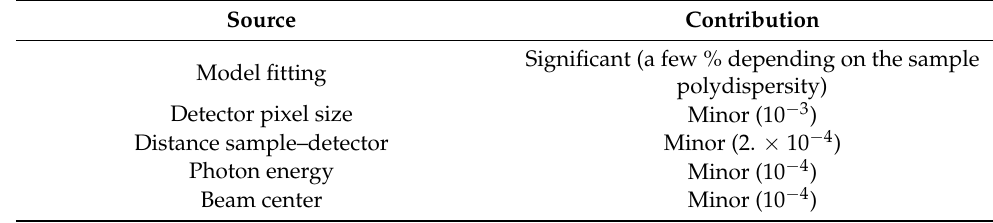
Table 6. Main uncertainty sources for NP size measurements by